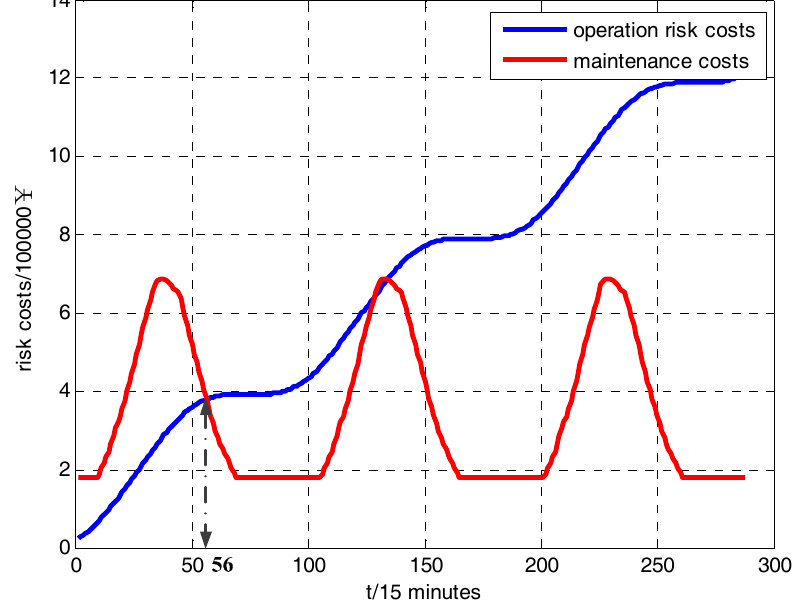
Figure 5. Curves of operation risk costs and active maintenance